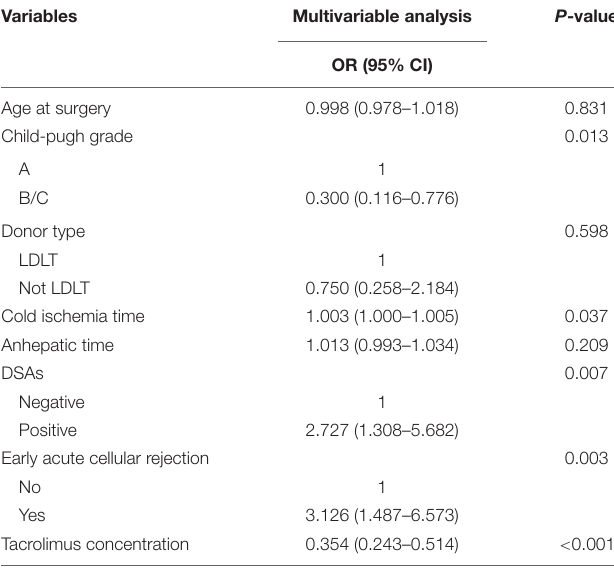
TABLE 4 | Results of multivariable logistic regression analyses.